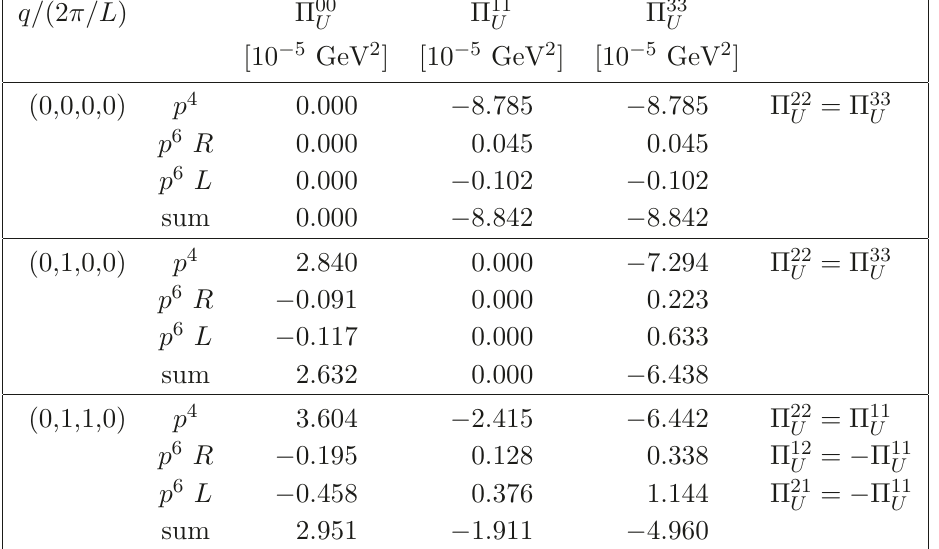
for the connected part for low U